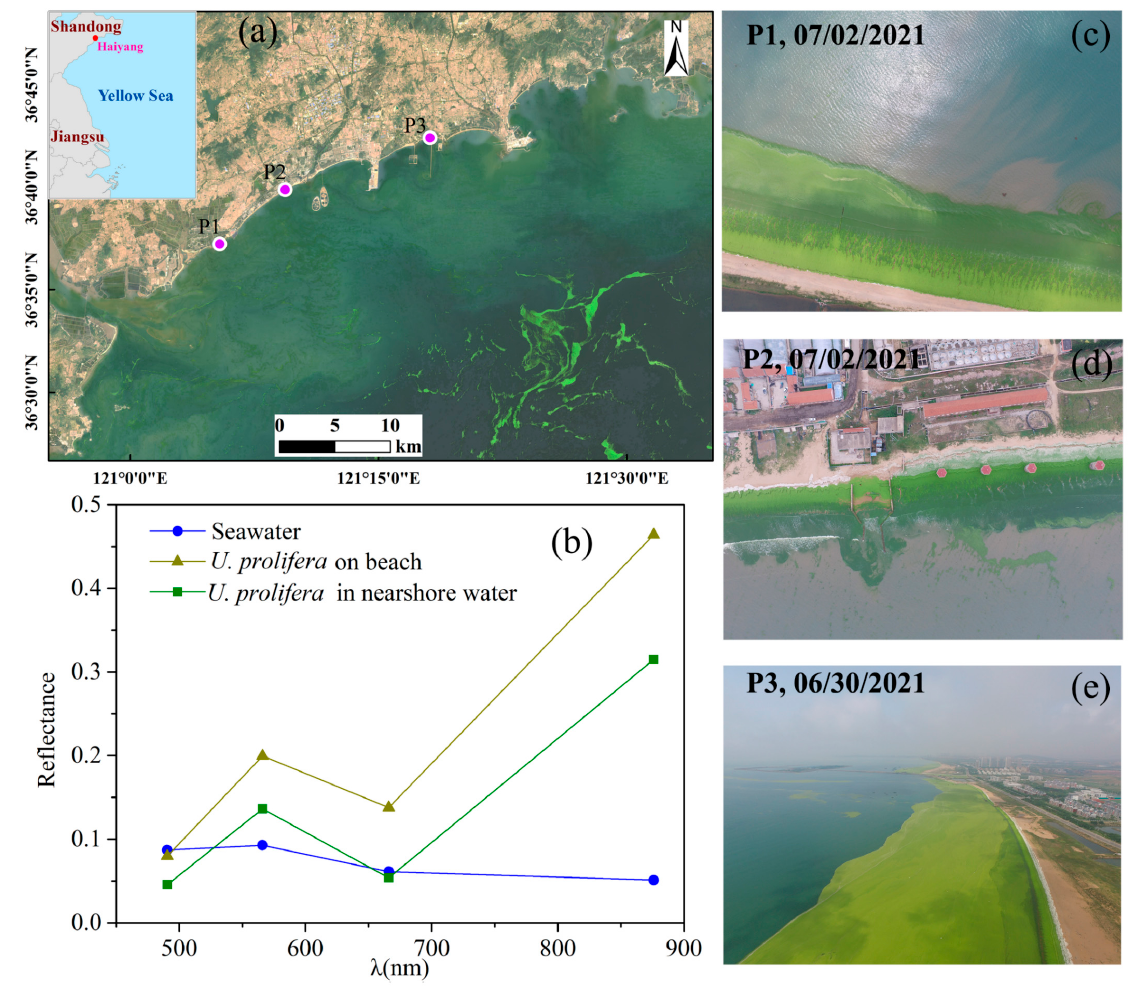
Figure 1. ( a ) The three research areas are denoted by the letters P1, P2, and P3, respectively. The background image is a Landsat 8 true color image composed of bands 4-3-2 on 23 June 2021 (source: https://earthexplorer.usgs.gov/, accessed on 23 June 2021). ( b ) Spectral reflectance of seawater, Ulva prolifera ( U. prolifera ) on the beach, and U. prolifera in nearshore water from the Super Dove multispectral image. ( c – e ) U. prolifera on the beach, shot by an unmanned aerial vehicle (UAV) at P1, P2, and P3 study